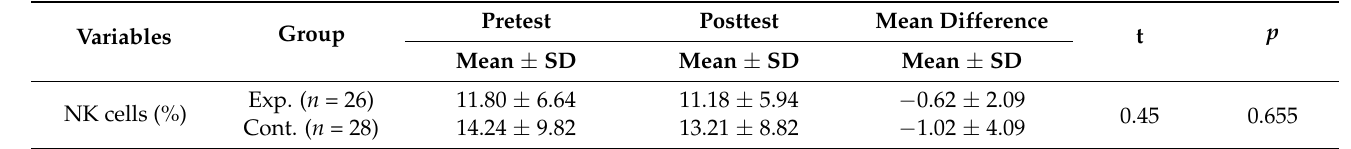
Table 6. Effect of indirect forest stimulation on NK cell levels ( n =